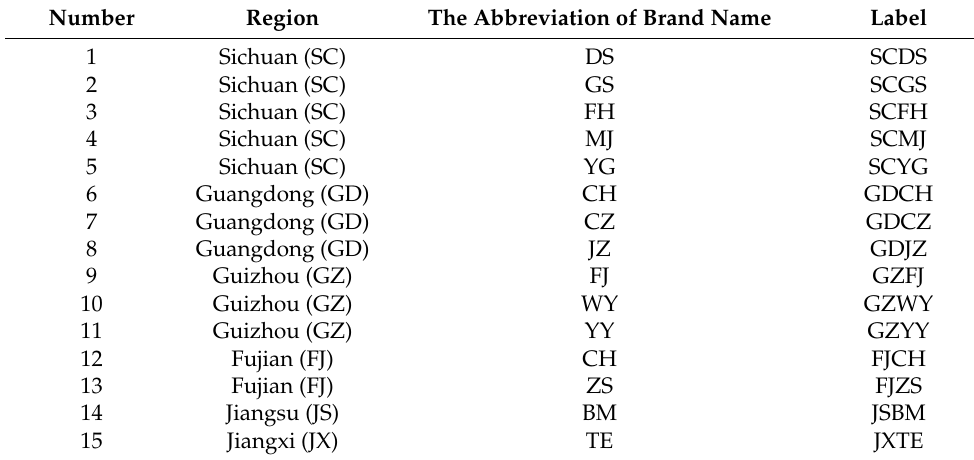
Table 1. All sample information and labels in this